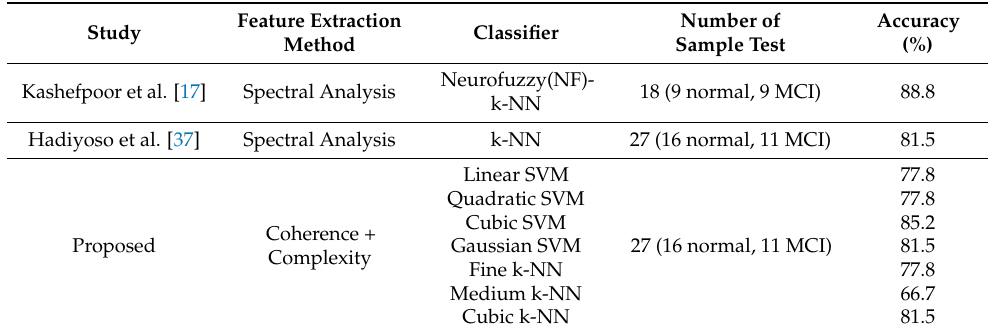
Table 15. Accuracy for AD dataset and comparison with previous